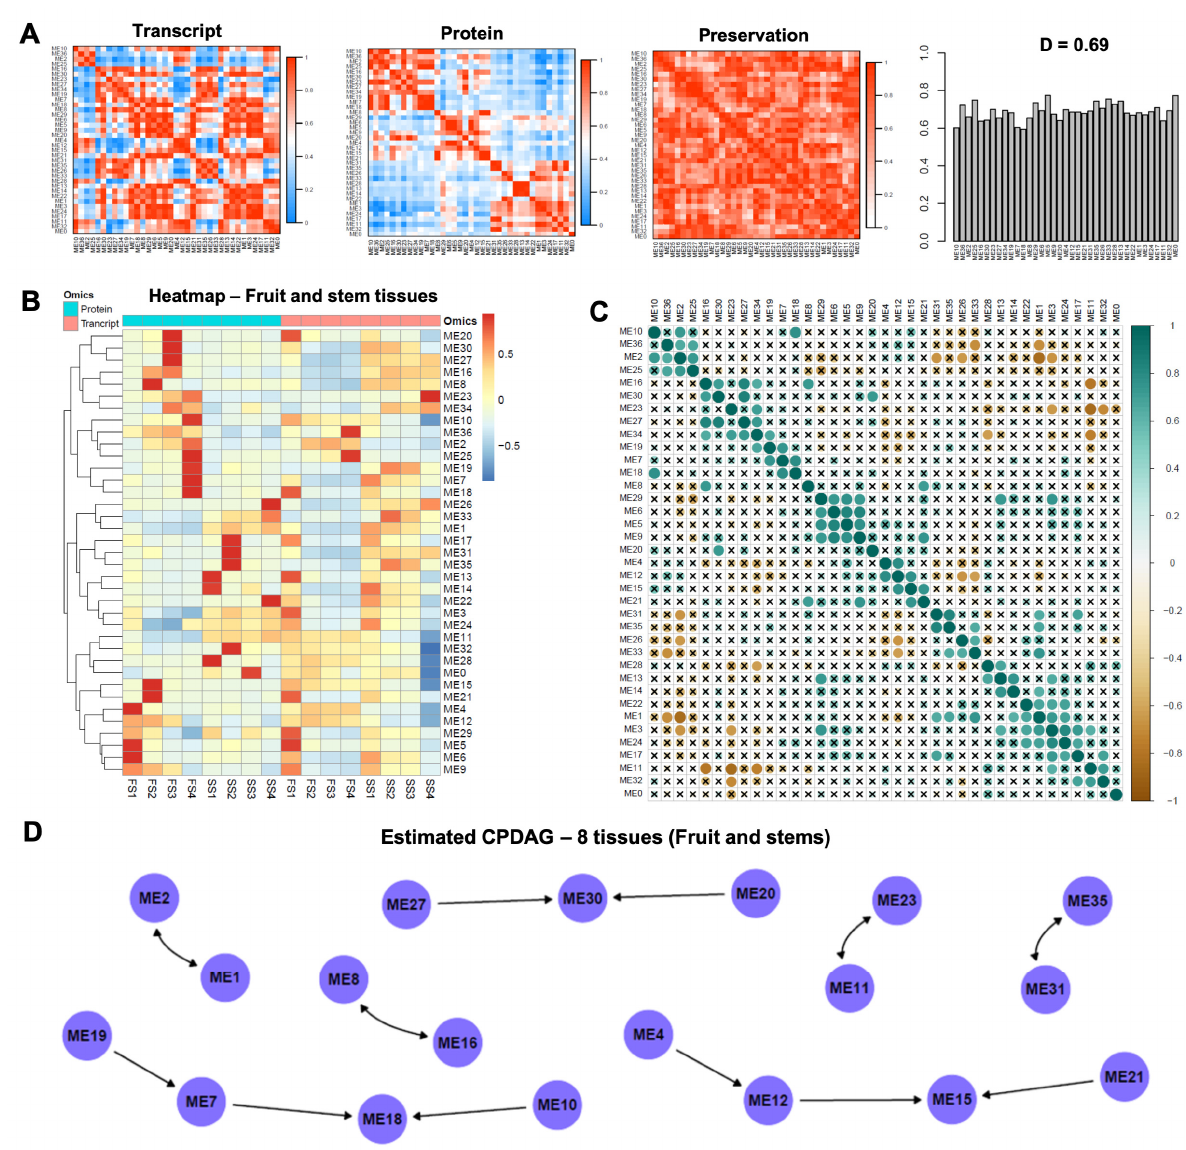
Figure 3. ( A ). Consensus eigengene networks are displayed and their differential analysis, based on the 8 tissues considered (FS1–FS4 and SS1–SS4). The first two plots show the eigengene networks heatmaps in the proteomic and transcriptomic datasets (labeled Transcript and Protein). In the heatmaps, the red color represents high adjacency between modules (i.e., positive correlation), and the blue color denotes low adjacency (i.e., negative correlation) between the corresponding modules. The preservation heatmap (3rd plot) shows the preservation network, defined as one minus the absolute difference of the two eigengene networks. The barplot (4th plot) shows the mean preservation of adjacency for each of the eigengenes to all other eigengenes (column means of the preservation heatmap). ( B ). Heatmap depicting the values of the consensus eigengenes (representing the consensus modules) at the 8 tissues considered (FS1–FS4 and SS1–SS4). The eigenegenes were clustered (by row) with hierarchical clustering. The distance measure used was the Euclidean distance and the clustering method was “complete”. The columns (tissues) were given in the same sequential order for the proteomic and transcriptomic (no clustering was performed by column). ( C ). Global correlation analysis (Pearson coefficient) for the 36 modules. The magnitude of the correlation is depicted in both the color and size of the spheres. Correlations which were not statistically significant at the 0.01 level were marked with an “x”. ( D ). The completed partially directed acyclic graph (CPDAG) is displayed. Both directed and bidirected edges are present in the causal